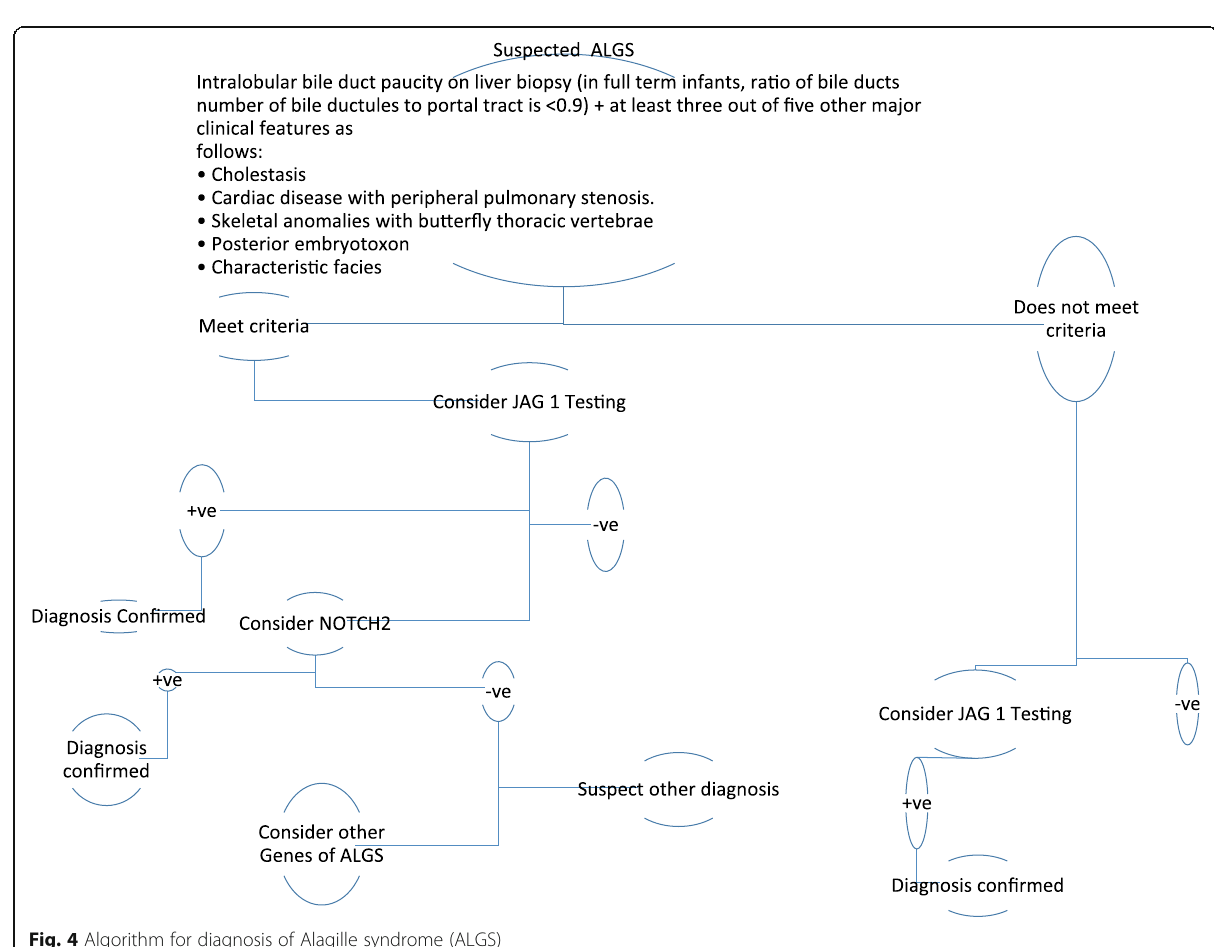
Fig. 4 Algorithm for diagnosis of Alagille syndrome